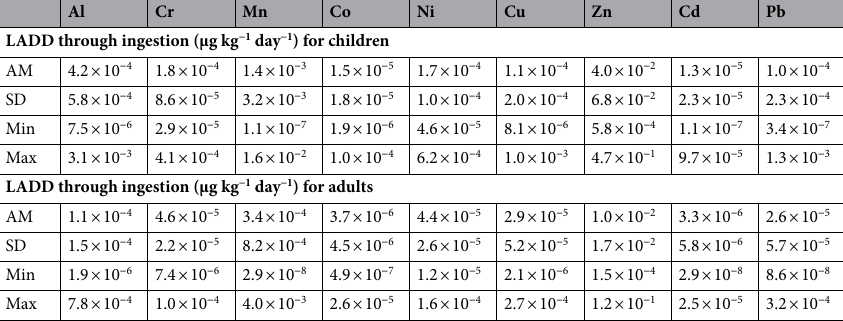
Table 9. Statistical parameters of the estimated LADD due to ingestion of HMs present in potable water.